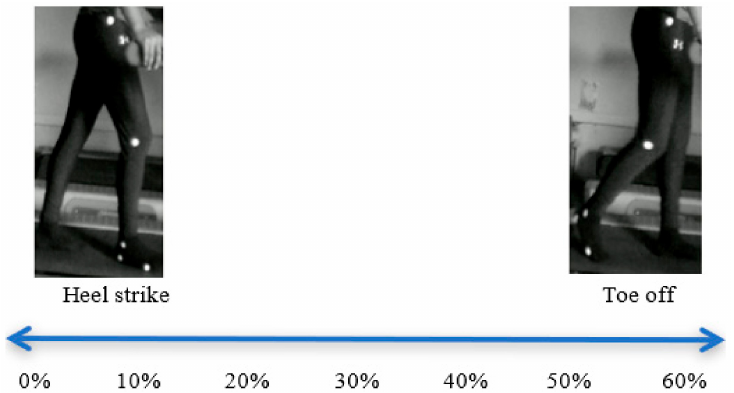
Figure 13. Case 3: Critical support phases for ANSYS ® prosthesis analysis.